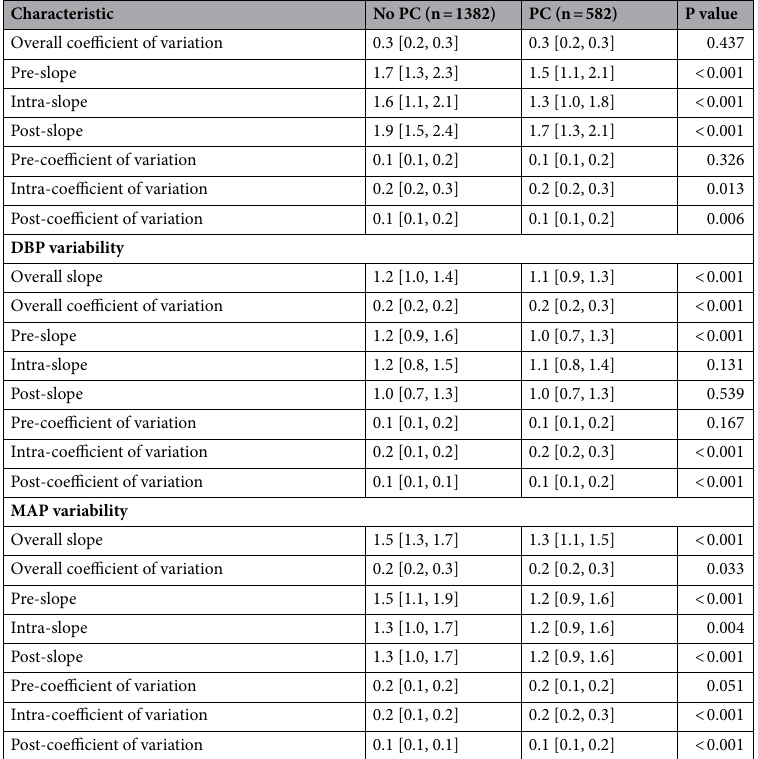
Table 1. Characteristics of cardiac patients stratified by postoperative complications (PC). ASD atrial septal defect, VSD ventricular septal defect, PDA patent ductus arteriosus, PFO patent foramen ovale, TOF tetralogy of fallot, TAPVC total anomalous pulmonary venous connection, LOS length of stay, SBP systolic blood pressure, DBP diastolic blood pressure, MAP mean arterial